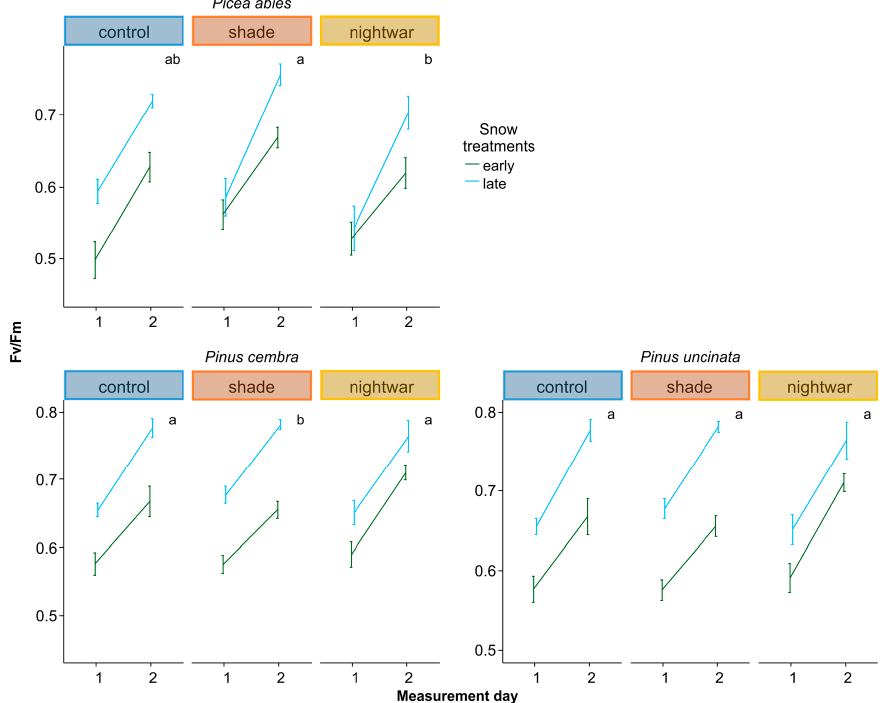
Figure 3. Pre-dawn quantum yield (chlorophyll fluorescence parameter Fv/Fm) of tree seedlings near the treeline in the French Alps, planted autumn 2013, measured after snowmelt 2014. Lines indicate snowmelt timing treatments: early (dark green) and late (blue). Columns correspond to sky-exposure treatments: control (no roof), shade (shade roof during the day), and nightwar = night warming (shade roof during the night). Shown are mean values (±se) based on 22 to 40 individuals per treatment combination (in four blocks). Measurement days were eight and 20 days (early plots) or eight and 16 days (late plots) after snowmelt. Time 2 for the early plots corresponds to time 1 for the late plots. Different letters indicate significant differences between microclimatic treatments within species (Table A1). Early and late snowmelt plots differed significantly overall (Table